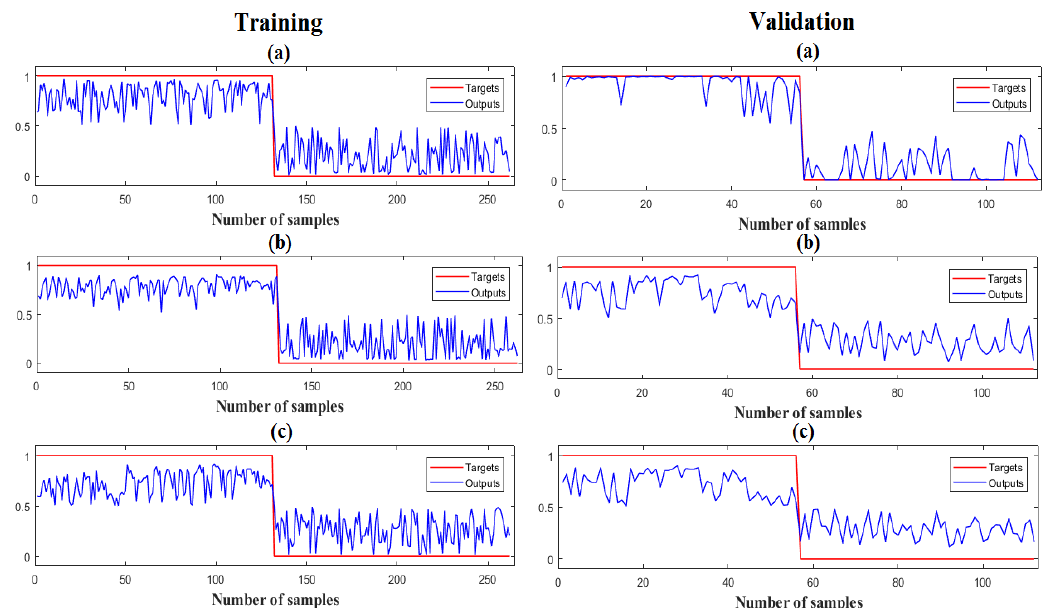
Figure A1. Results of the hybrid models: ( a ) BayesNet-GA, ( b ) BayesNet-SA, ( c ) BayesNet-TS. Figure 1. Research methodology. TWI: topographic wetness index, GA: genetic algorithm, SA: simulated annealing, TS: Tabu search, RMSE: root mean square error, MAE: mean absolute error, ROC: receiver operating characteristic, AUC: area under the